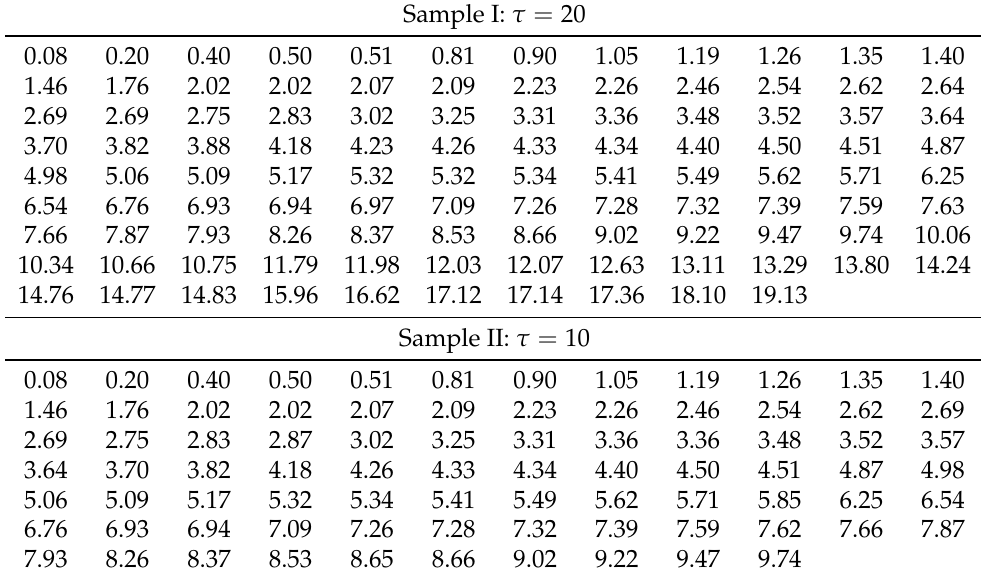
Table A6. The generated censored samples using data from Table